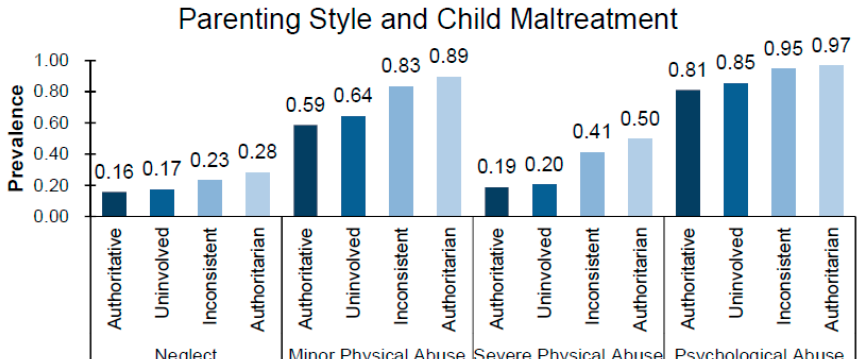
Figure 1. Association between categories of parenting style and child maltreatment.